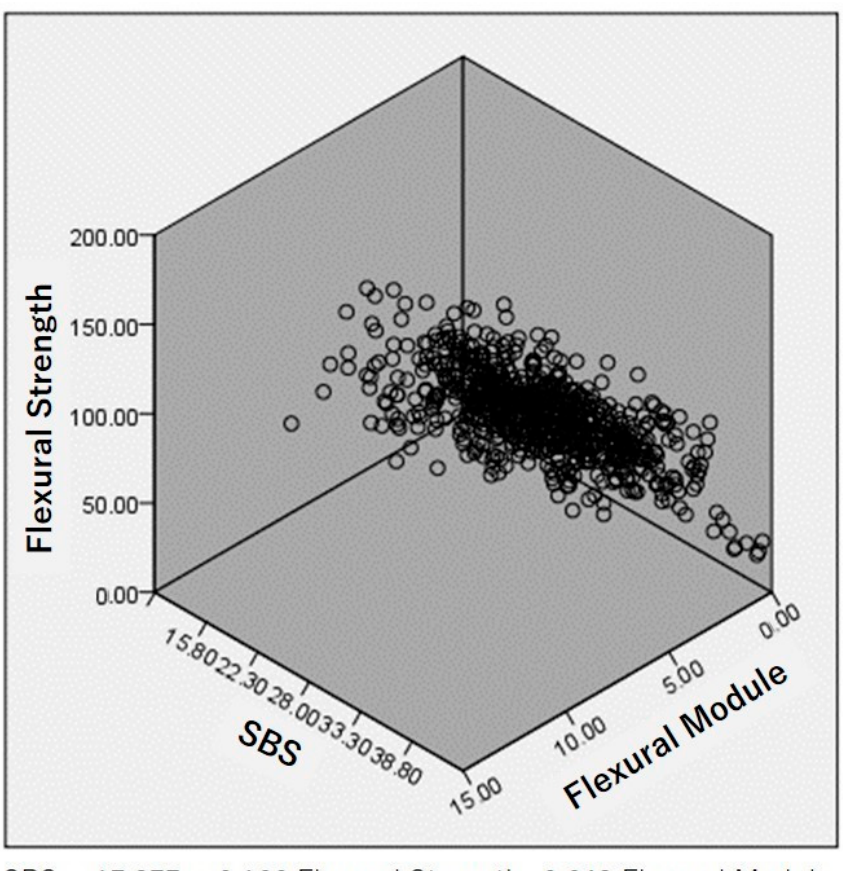
Figure 3. Correlation between shear bond strength to IPS e.max CAD, flexural strength, and flexural modulus of elasticity ( R 2 = 0.260, p <